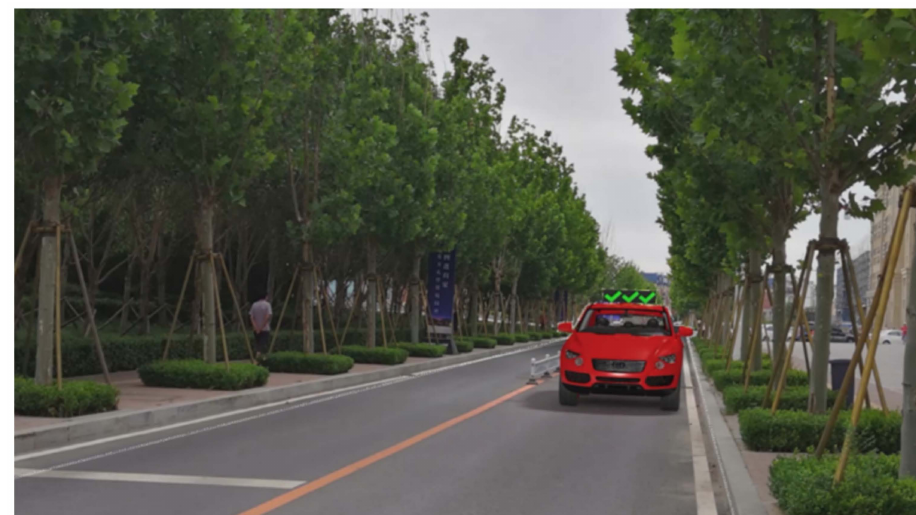
Figure 1. The cropped screenshots of the videos, showing the eHMIs used in this study for the roof position.